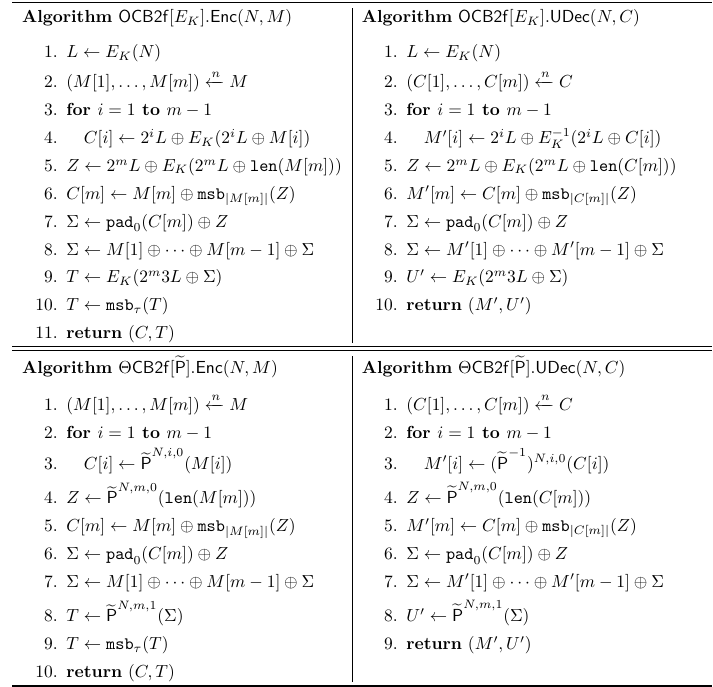
Figure 10: (Top) Encryption and Unfinished Decryption of OCB2f for empty AD. len : { 0 , 1 } ≤ n → { 0 , 1 } n is an injective length-encoding function. (Bottom) TURP-based idealization of OCB2f , Θ CB2f .